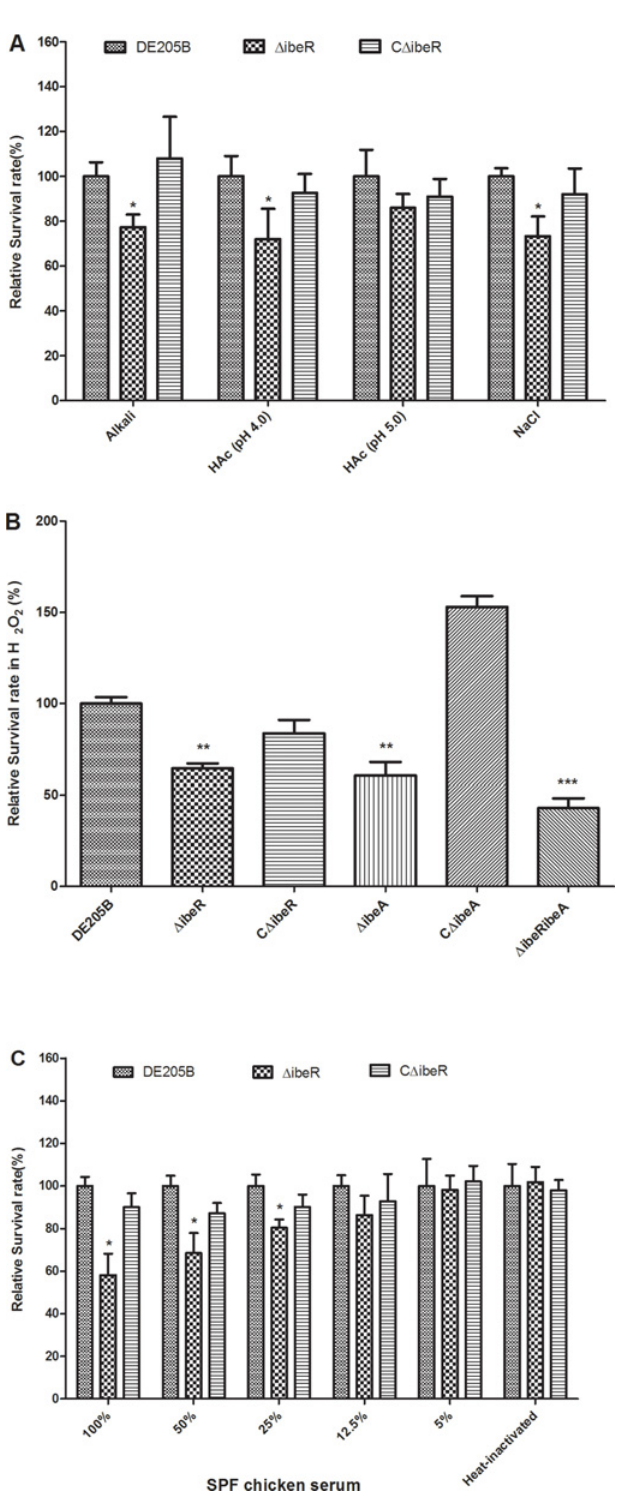
Fig 2. Bacterial resistance to environmental stress and SPF chicken serum. (A) Resistance to environmental stress. Each strain was tested for different environmental stress including alkali endurance (pH 10 for 30 min), acid endurance (acetic acid, pH 4.0 and pH 5.0 for 20 min) and high osmolarity challenge (2.4 M NaCl for 1 h). Results were expressed as survival relative to wild-type strain DE205B. Survival of